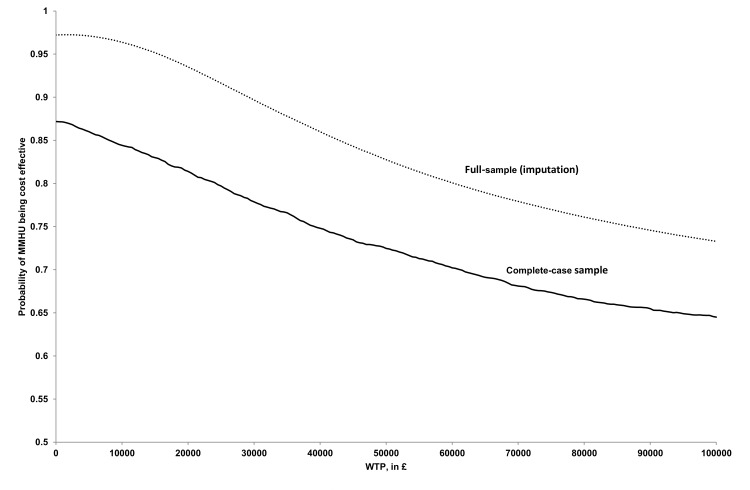
Cost-effectiveness acceptability curves (adjusted analyses)–full sample and complete-case analyses.Full-sample cost-effectiveness acceptability curve is obtained from probability of cost-effectiveness for given ceiling ratio, averaged across 100 imputations. CEACs represent probability of cost-effectiveness of MMHU for given WTP, where WTA is assumed to be equal to WTP (SW quadrant of cost-effectiveness plane, see Figs 1 and 3).